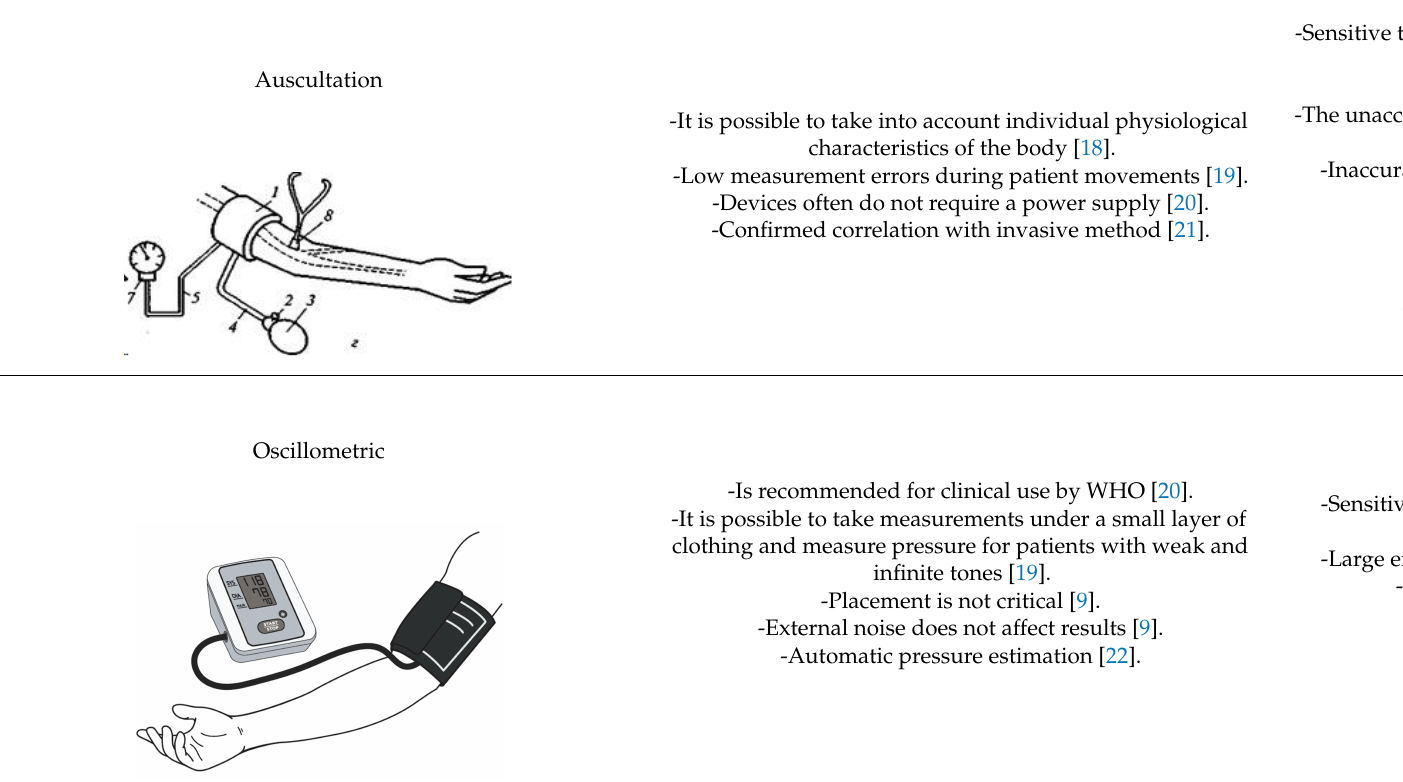
Table 1. Blood pressure estimation techniques.